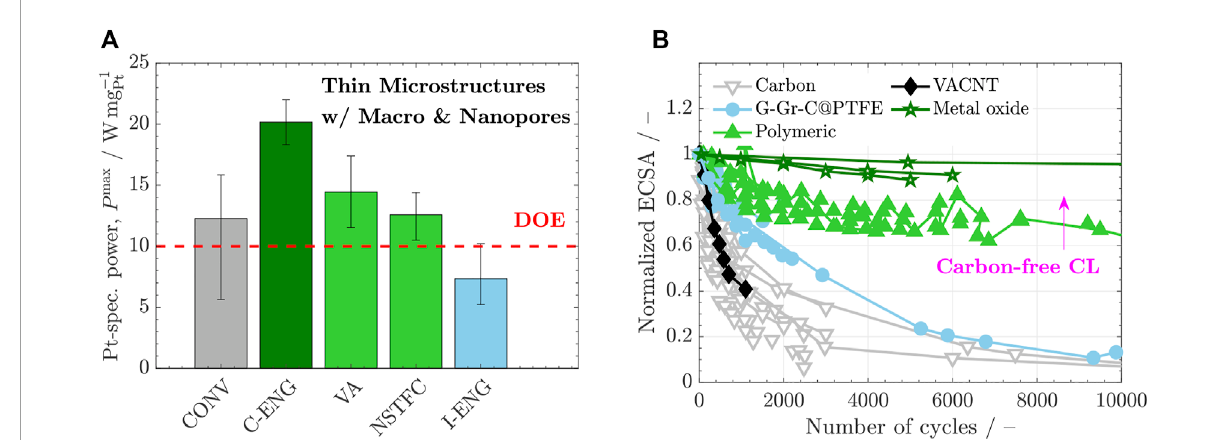
FIGURE 1 (A) Peak power per Pt miligram, P max , achieved with different cathode CL designs: CONV, conventional CLs with solid (Vulcan) and nanoporous (e.g., KetjenBlack) carbon supports prepared by different techniques (e.g., airbrush or electrospraying) (Orfanidi et al., 2017; Garsany et al., 2018; Conde et al., 2019; Talukdar et al., 2019; Cui et al., 2021); CONV-ENG, conventional CLs with engineered or modified nanoporous supports (Yarlagadda et al., 2018; Ramaswamy et al., 2020); VA, CLs with vertically aligned supports covered by ionomer (i.e., based on Middelman’s ideal microstructure) (Murata et al., 2014; Xia et al., 2015; Meng et al., 2022); NSTFC, ionomer-free nanostructured thin film catalysts Debe (2012); Debe et al. (2011); Debe (2011); Debe et al. (2006); Ostroverkh et al. (2019); ION-ENG, CLs with engineered or modified ionomer distributions (e.g., a combination of ionomer nanofibers and conventional microstructures with reduced ionomer content) (Zhang and Pintauro, 2011; Borup and Weber, 2019; Sun et al., 2019; Yoshino et al., 2020). The 2020 DOE target, P ≈ 10 W mg − 1 , is indicated by a red dashed line. Baseline Pt operating conditions: air/H 2 , temperature, T = 70 − 80 ° C, relative humidity, RH = 1, cathode back pressure, p c = 150 kPa( abs ). (B) Normalized ECSA with respect to BOL as a function of the number of cycles in ASTs for different catalyst supports: Carbon, CLs supported on conventional carbon nanoparticles ((Babu et al., 2021) and other references included herein); G-Gr-C@PTFE, CLs supported on either graphitized carbon, graphene or PTFE-doped carbon nanoparticles (Wang et al., 2019; Babu et al., 2021; Pushkareva et al., 2021); VACNT, CLs based on vertically aligned carbon nanotubes covered by ionomer (Murata et al., 2014; Meng et al., 2022); Polymer, CLs based on polymer whiskers without (e.g., NSTFC (Debe et al., 2006; Debe, 2011; Debe et al., 2011; Debe, 2012; Ostroverkh et al., 2019)) and with (Xia et al., 2015) ionomer films;